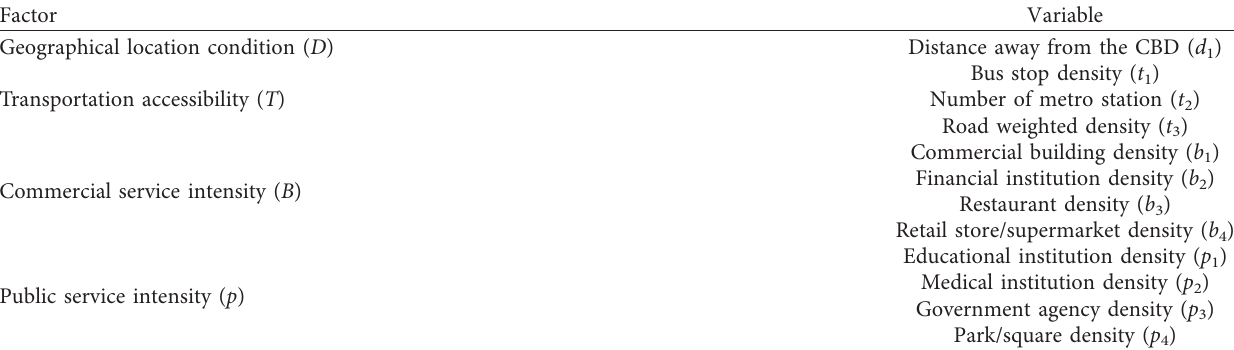
Table 1: Selection of the influencing factors and their variables.